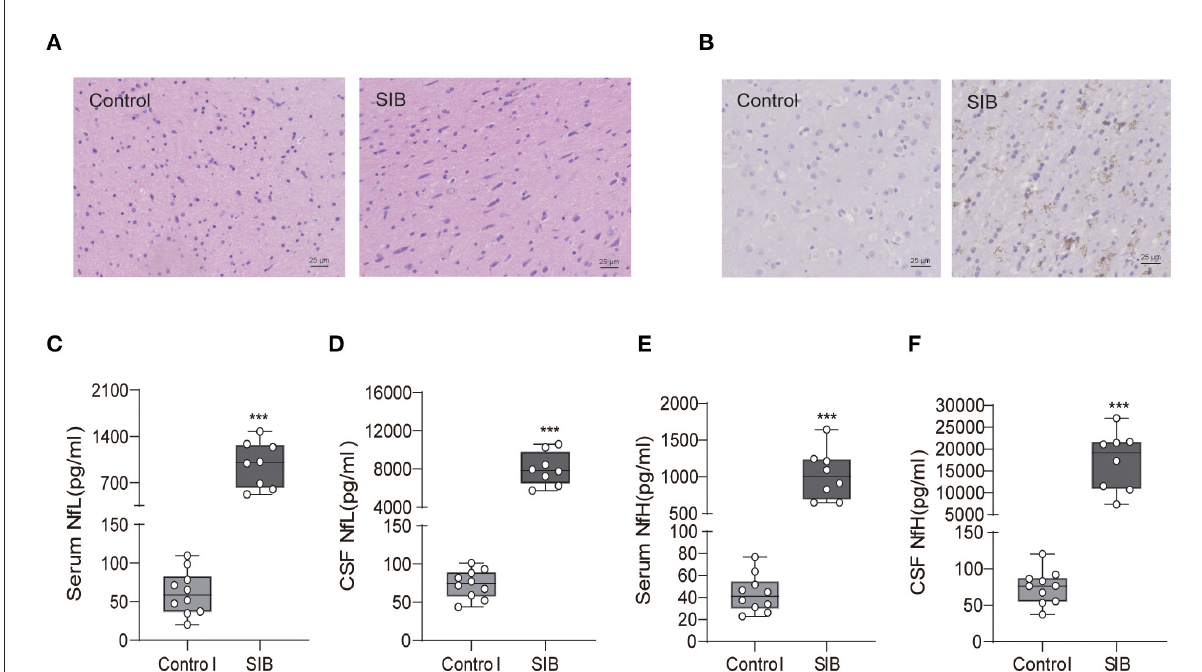
FIGURE2 Minks with SIB exhibit serious nerve damage in brain tissues. (A) Microglial cells diffused hyperplasia in the brain parenchyma in SIB. Representative HE staining in the brain tissues, Scale bars, 25 µ m. (B) Activated Iba-1 microglial cells were increased in SIB group. Representative IHC stains of Iba-1 in the brain tissues. Scale bars, 25 µ m. IHC, Immunohistochemistry. Ten mink brain tissues in Control group, eight mink brain tissues in SIB group and three micrographs per individual were performed for the photomicrographs. (C–F) The levels of NfL and NfH in control and SIB group. Each symbol represents the serum and CSF cytokine levels (pg/ml) in one mink. Data shown represent the mean ± SEM; Control, n = 10; SIB, n = 8. *** p < 0.001.